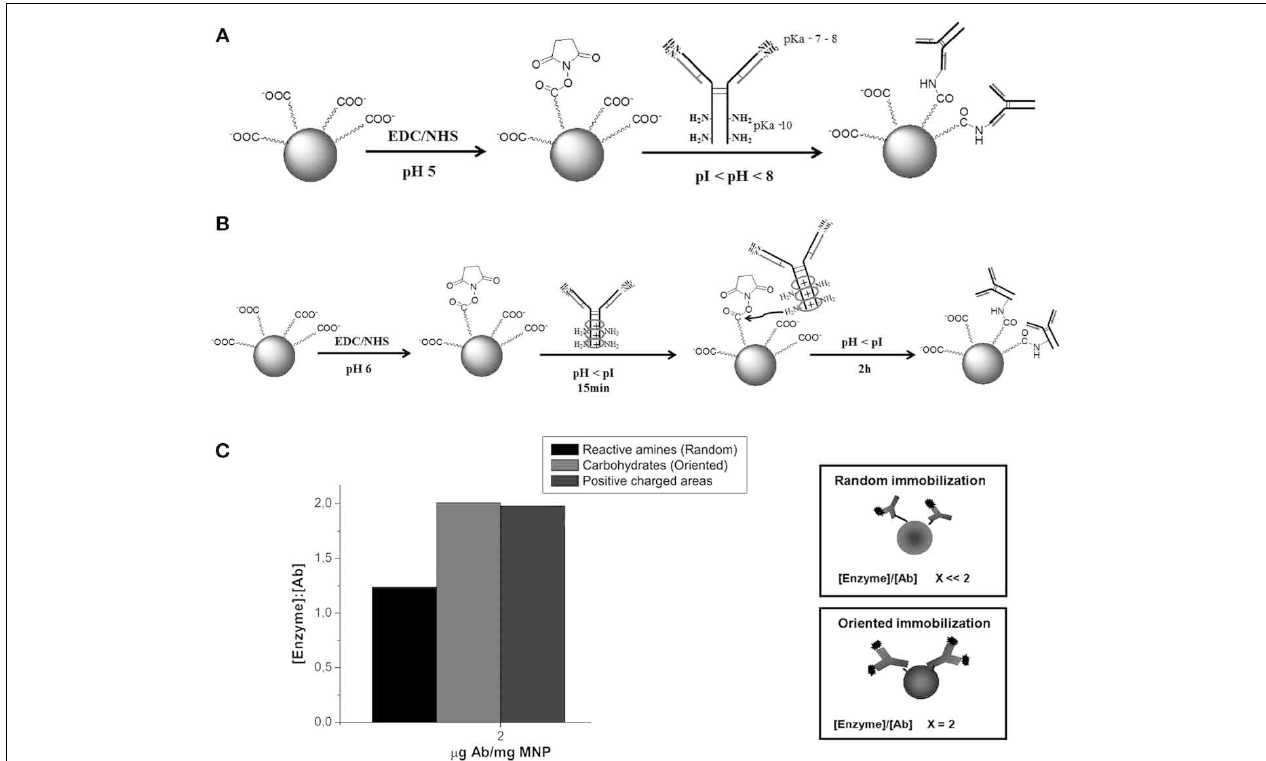
FIGURE 9 | Highly active magnetic nanoparticle-antibody conjugates. (A) Two-step immobilization mechanism proposed when using Ab that bind to the MNPs through the most reactive amines—random immobilization. (B) Covalent attachment via the polysaccharide moieties of the antibody to the